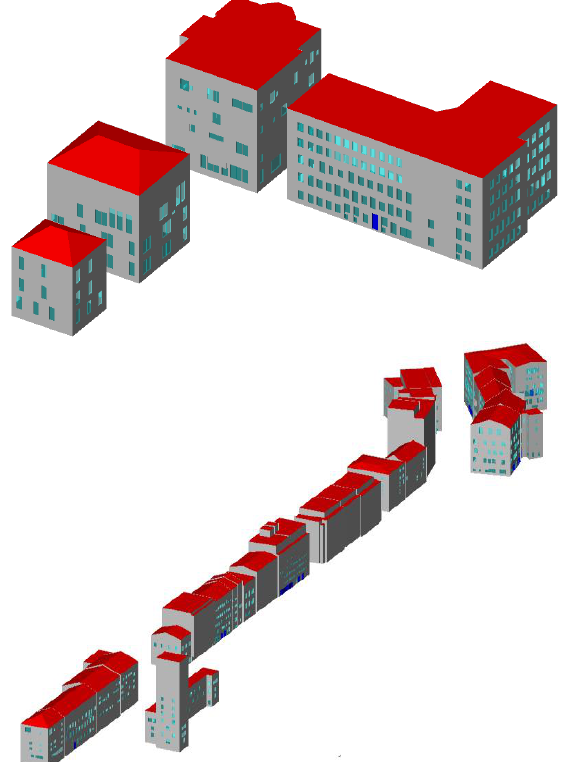
Figure 9. LOD3 results for grammar based modelling